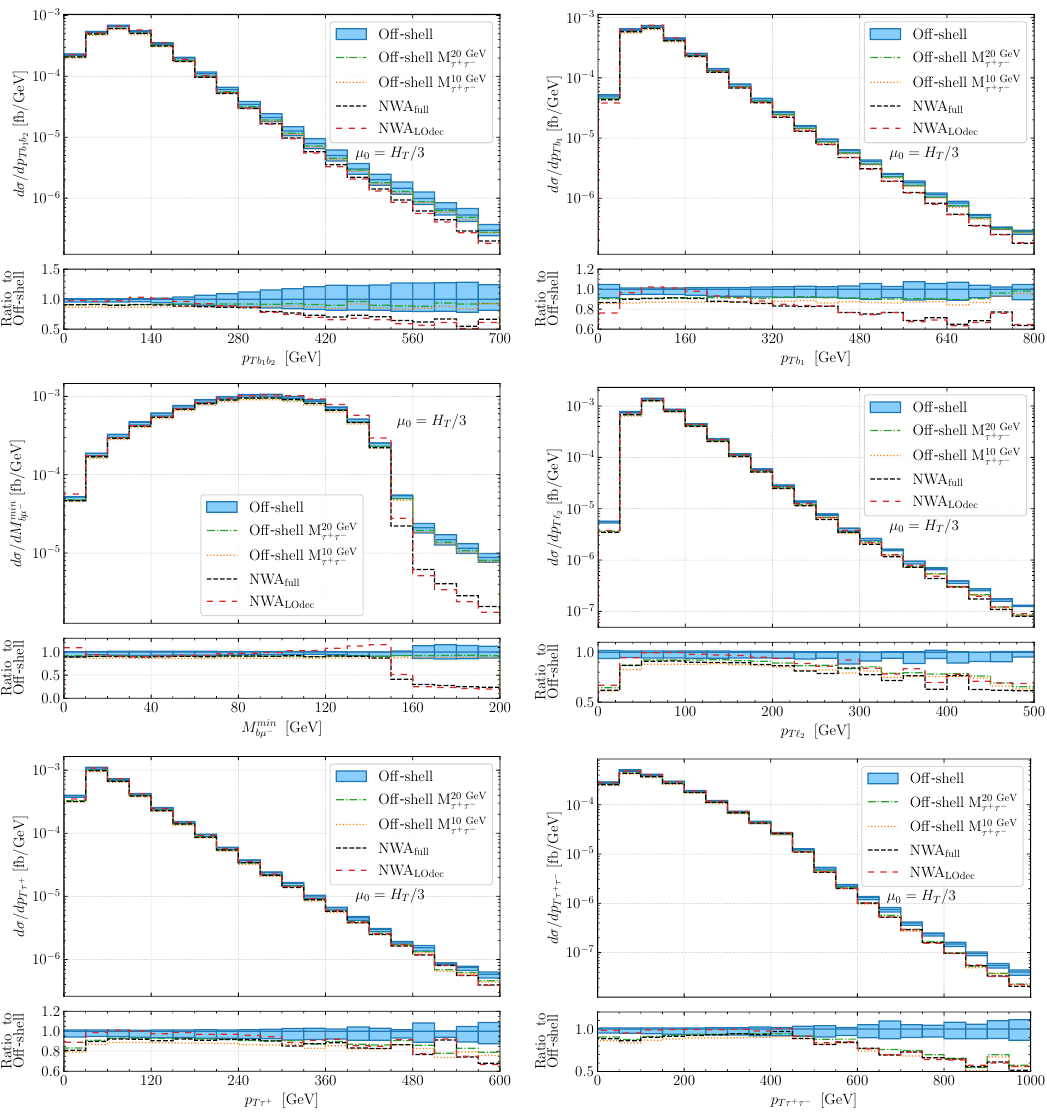
Figure 11 . Differential cross-section distributions for pp → e + ν e µ − ¯ ν µ b ¯ b τ + τ − + X at the LHC √ with s = 13 TeV as a function of p shows the NLO QCD prediction for the full off-shell case as well as for NWA full and NWA LOdec . Also given is the full off-shell result with the additional | M we provide theoretical uncertainties as obtained from the scale dependence for the full off-shell case. The lower panel displays the ratios to the full off-shell result. The scale choice is µ R = µ F = µ 0 = H T / 3 . The cross sections are evaluated with the NNPDF3.1 PDF